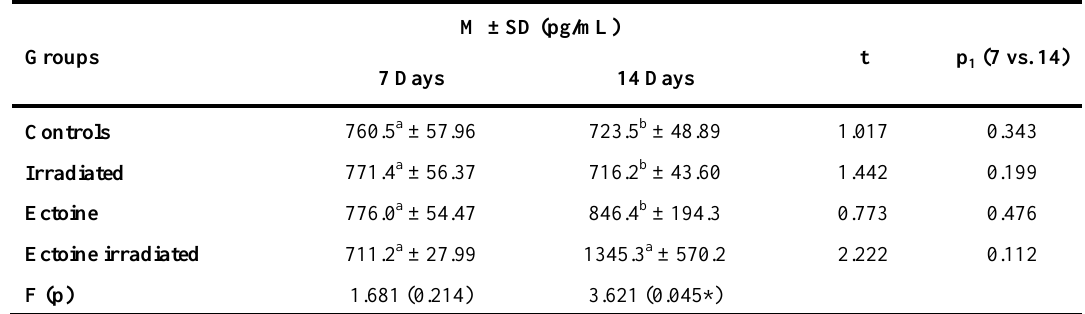
Table 4. The effect of ectoine on serum Apoptosis Inducing factor (AIF) in the model of irradiation-induced cardiotoxicity in female albino